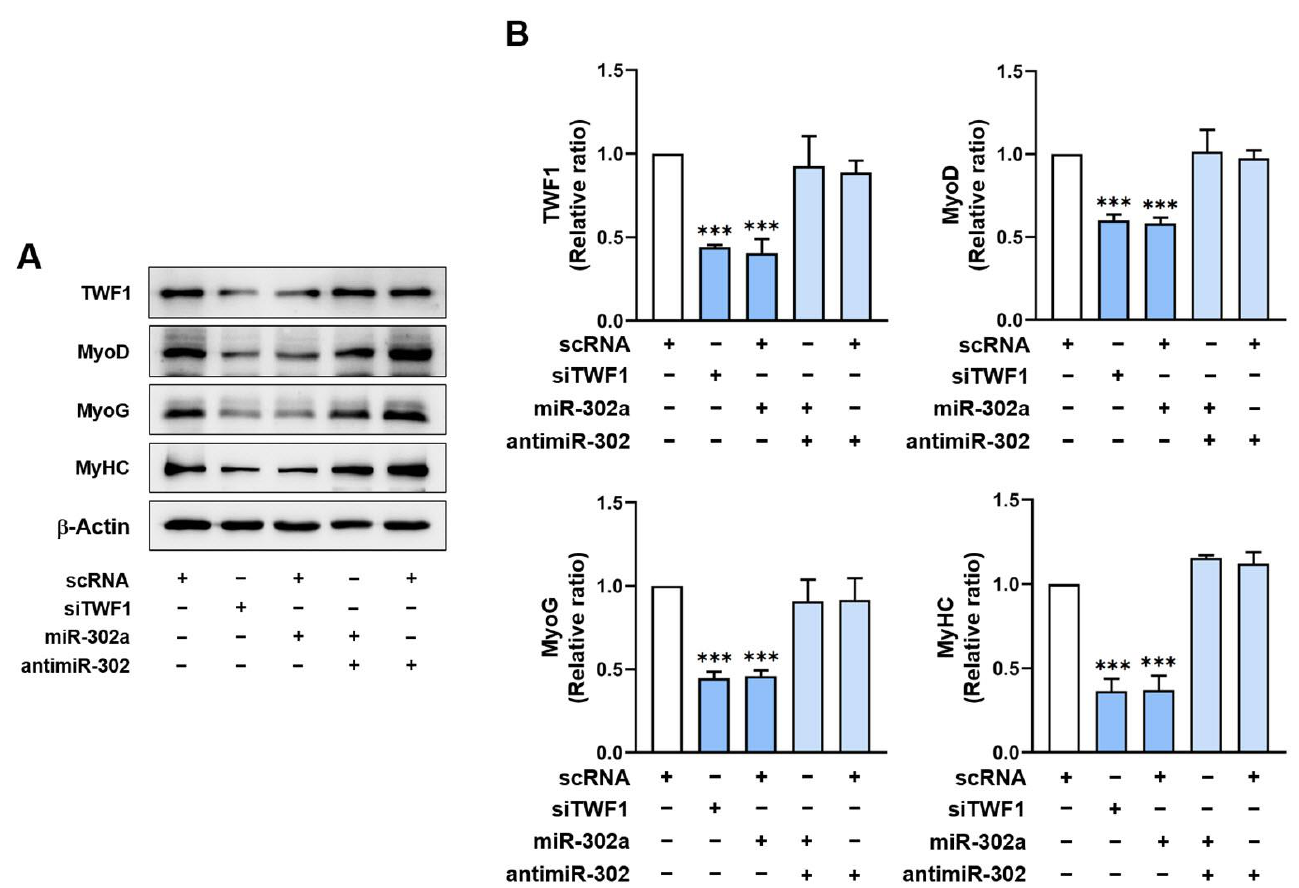
Figure 5. MiR-302a inhibits the expressions of myogenic factors and TWF1. C2C12 cells were trans- fected with scRNA, siTWF1, miR-302a mimic, or antimiR-302 and differentiated for 3 days. ( A ) Rep- resentative immunoblots of MyoD, MyoG, MyHC, and TWF1 with β -actin are shown. ( B ) Quanti- tative analysis of TWF1 and myogenic factor (MyHC, MyoD, and MyoG) protein levels. Intensities of immunoblots were normalized versus β -actin via densitometry. Values are relative ratios versus controls (scRNA). Results are presented as means ± standard errors ( n > 3); ***, p < 0.001 vs. scRNA.